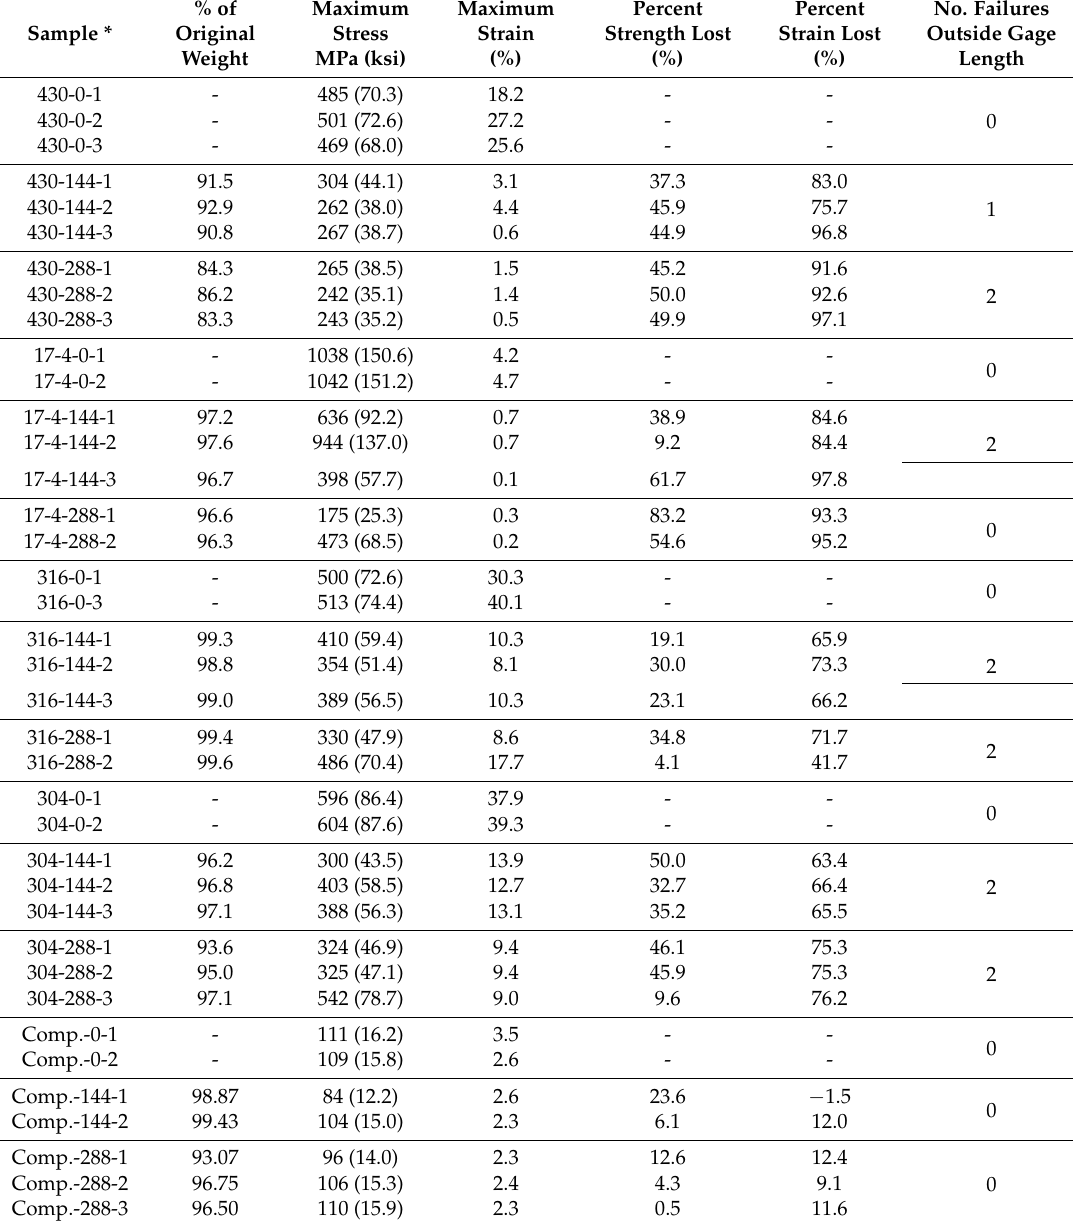
Table 2. Percent of original weight, maximum stress, maximum strain, percent strength lost, and percent strain lost for each sample. Number of failures outside the gage length for each sample type is also